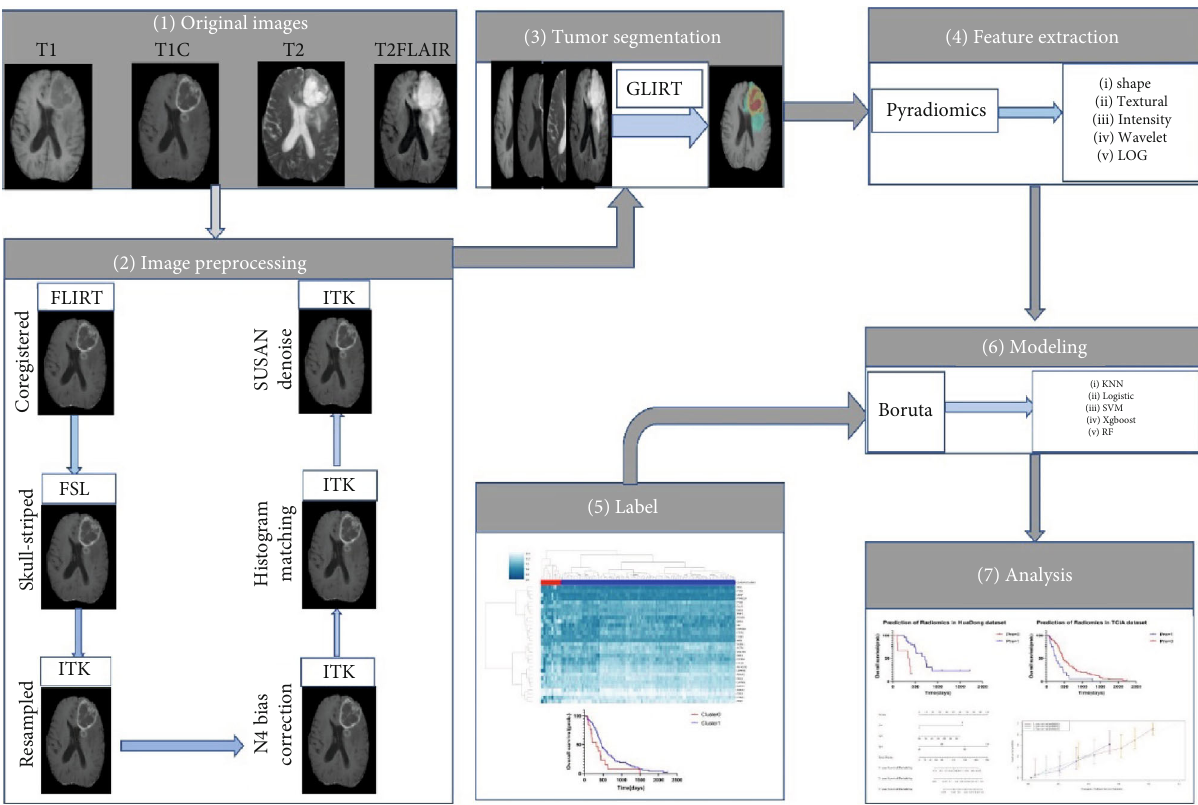
Figure 1: A fl owchart describing the radiomics method for prediction of radiotherapy response. (1) Preprocess the original image; (2) delineate the subregion ROI by GLISTR; (3) feature extraction using pyradiomics; (4) 31-gene signature were used to predict the result of the corresponding data, and a label was generated. (5) Feature selection by the Boruta algorithm; (6) modeling by a variety of machine learning methods, ROC curve, and AUC evaluation model; (7) building a prediction model by combining radiomics signature features and clinical features, fi nally displaying the OS prediction results by